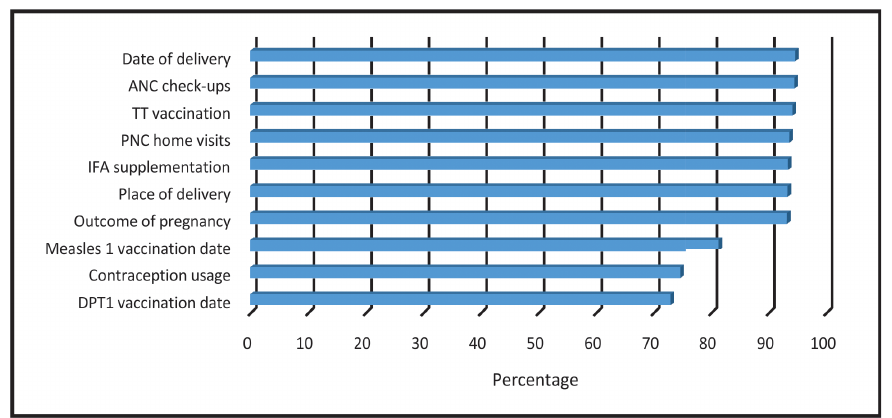
Fig 1. Completeness of health management information system at sub-centre level in Haryana state,